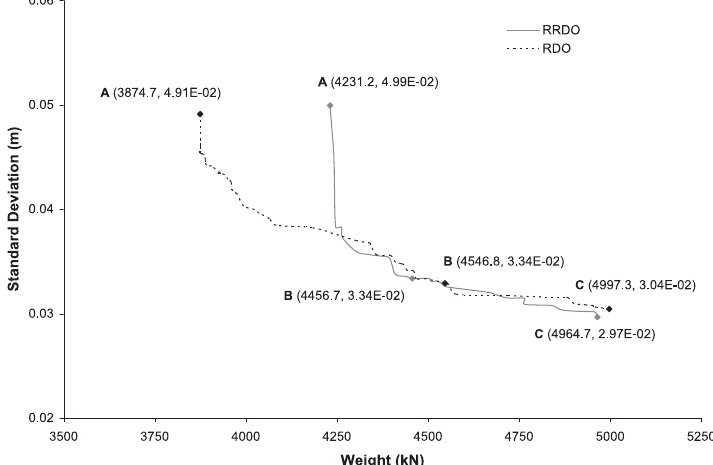
Fig. 8. 3D truss tower: comparison of the Pareto front